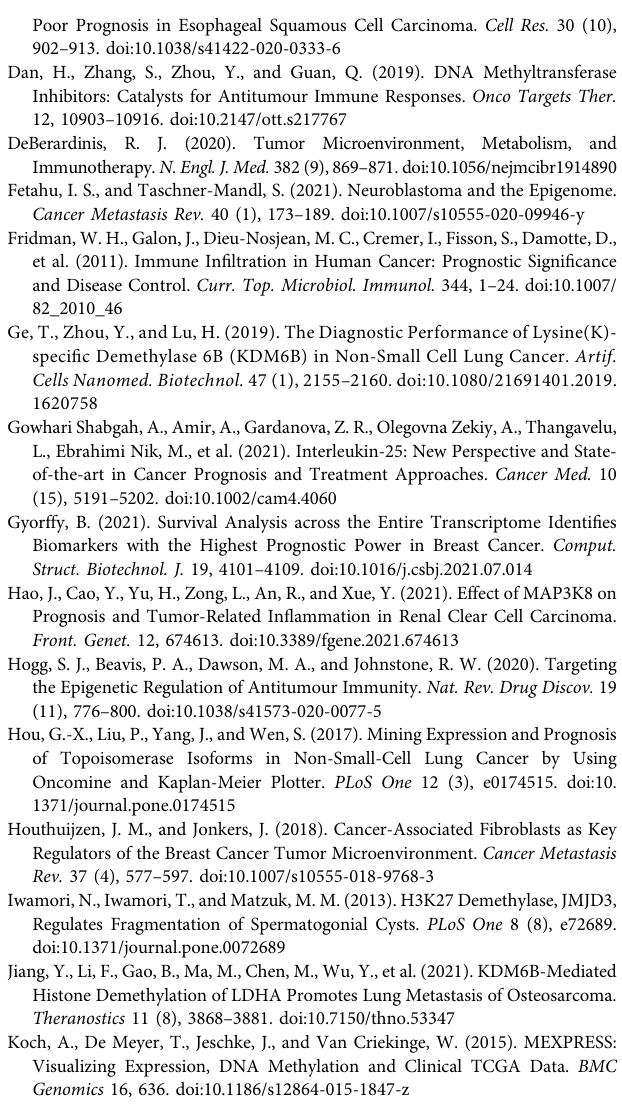
Supplementary Figure S1 | Correlation between KDM6B expression and different stages of KIRC and OV. Supplementary Figure S2 | Association between KDM6B and DNA methylation. Supplementary Figure S3 | Correlation analysis between the KDM6B expression and immune in fi ltration with CIBERSORT, CIBERSORT-ABS, TIMER, xCell, McP- counter, quanTIseq, and EPIC algorithms. p -values < .05 were considered statistically signi fi cant. Supplementary Table S1 | Spearman correlation analysis between the KDM6B expression levels and tumor mutational burden (TMB) and microsatellite instability (MSI). Supplementary Table S2 | Detailed results of the GO and KEGG analyses of KDM6B-related